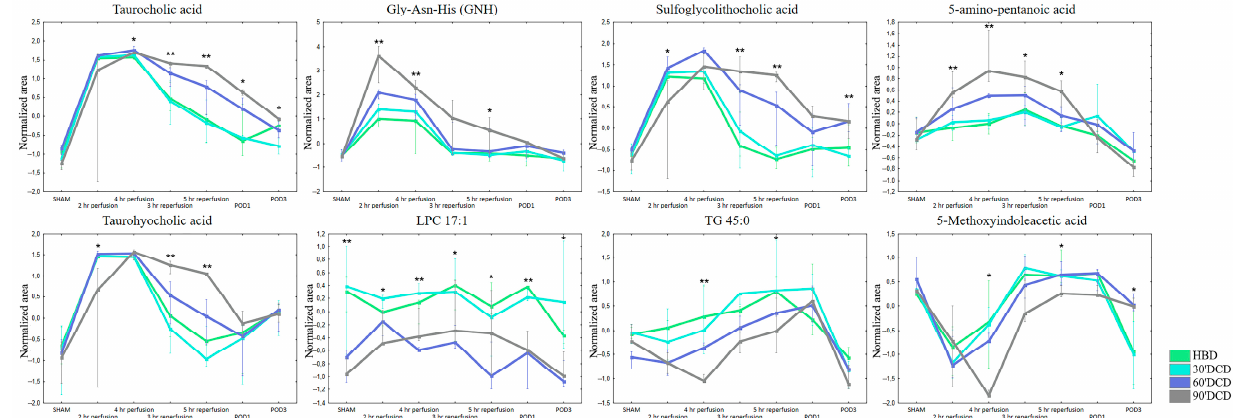
Figure 6. Changes in the levels of selected metabolites in the peri-transplant period. The plots display the medians of the normalized peak areas. The upper whisker denotes the largest data point, excluding any outliers, while the lower whisker indicates the lowest data point, excluding any outliers. *— p < 0.05; **— p <